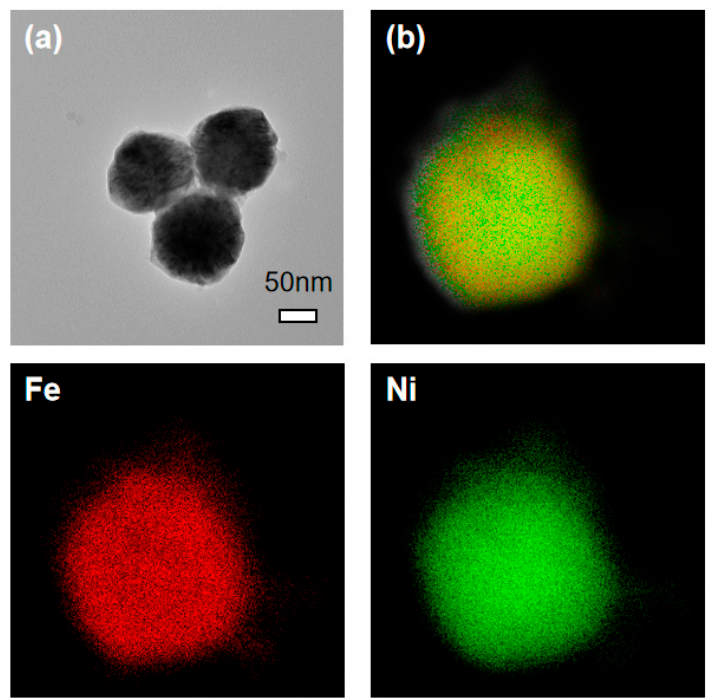
Figure 3. TEM image ( a ) and elemental mapping image ( b ) of FeNi 3 alloy.